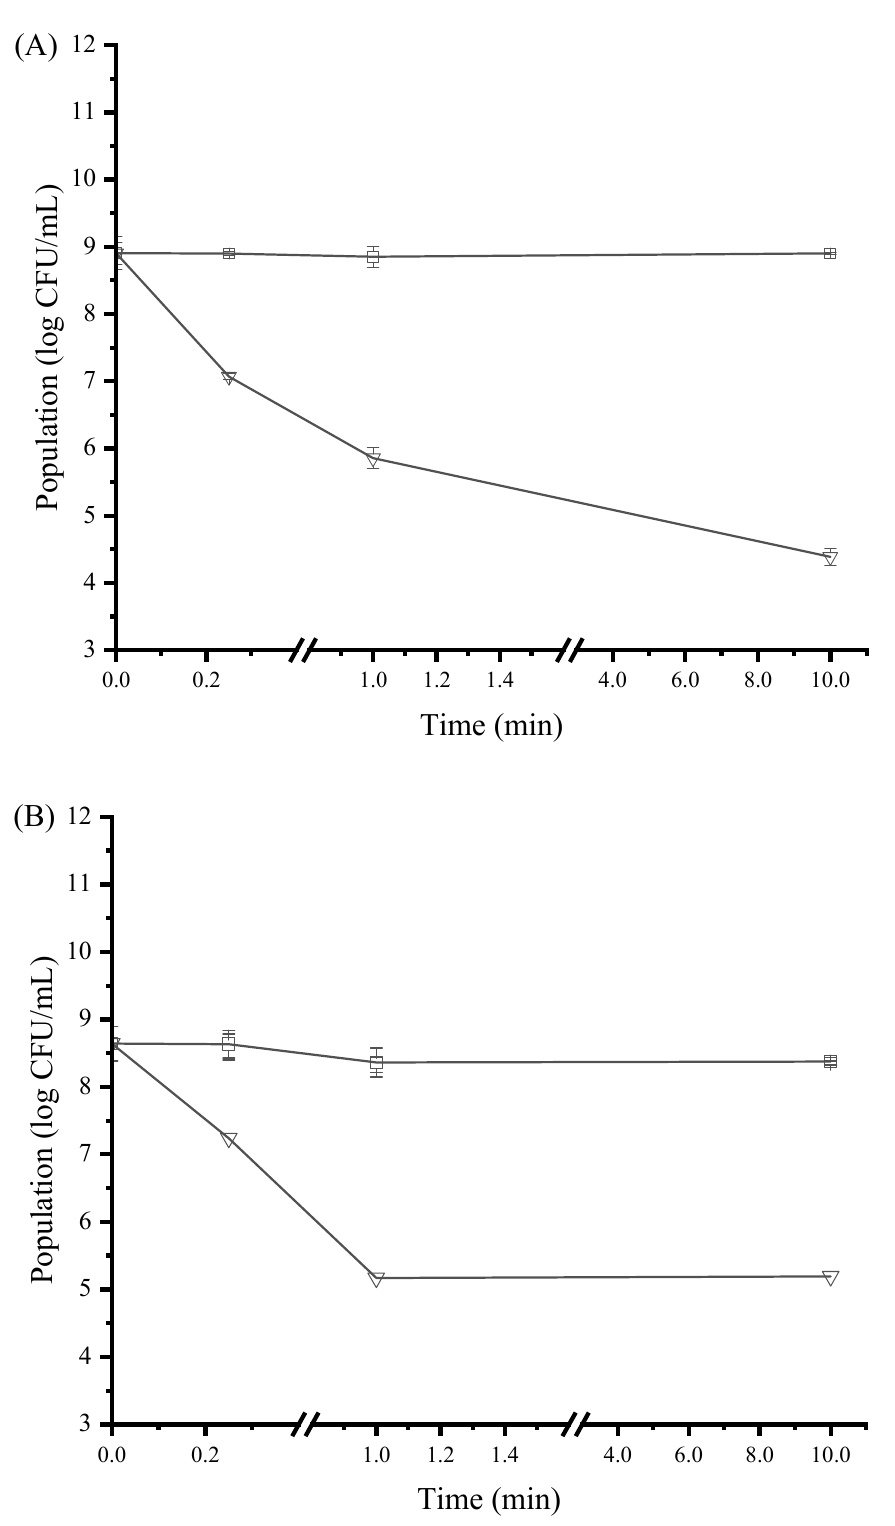
Figure 3. The population of E. coli ( A ) and S. aureus ( B ) during exposure to different concentrations of SAMs in NB at 37 °C for 10 min. The following concentrations of SAMs were used: control ( □ ) and 1 × MIC ( ▽ ). NB, nutrient broth. Values are displayed as the mean ± standard deviation. Error bars show standard deviations, which have been plotted for all data points. Symbols without visible vertical bars suggest that the symbol size is larger than the standard deviation.